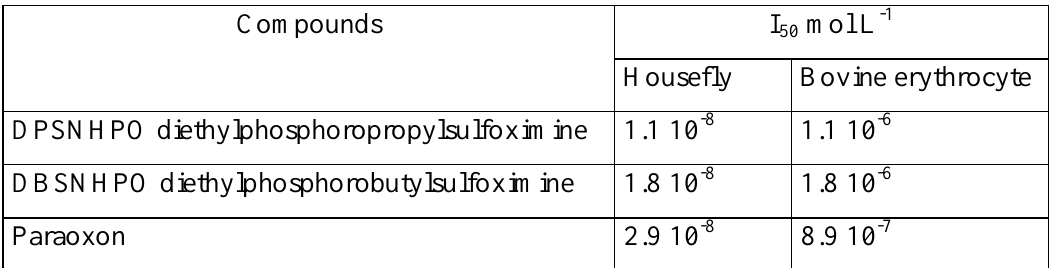
Table 2. Anticholinesterasic